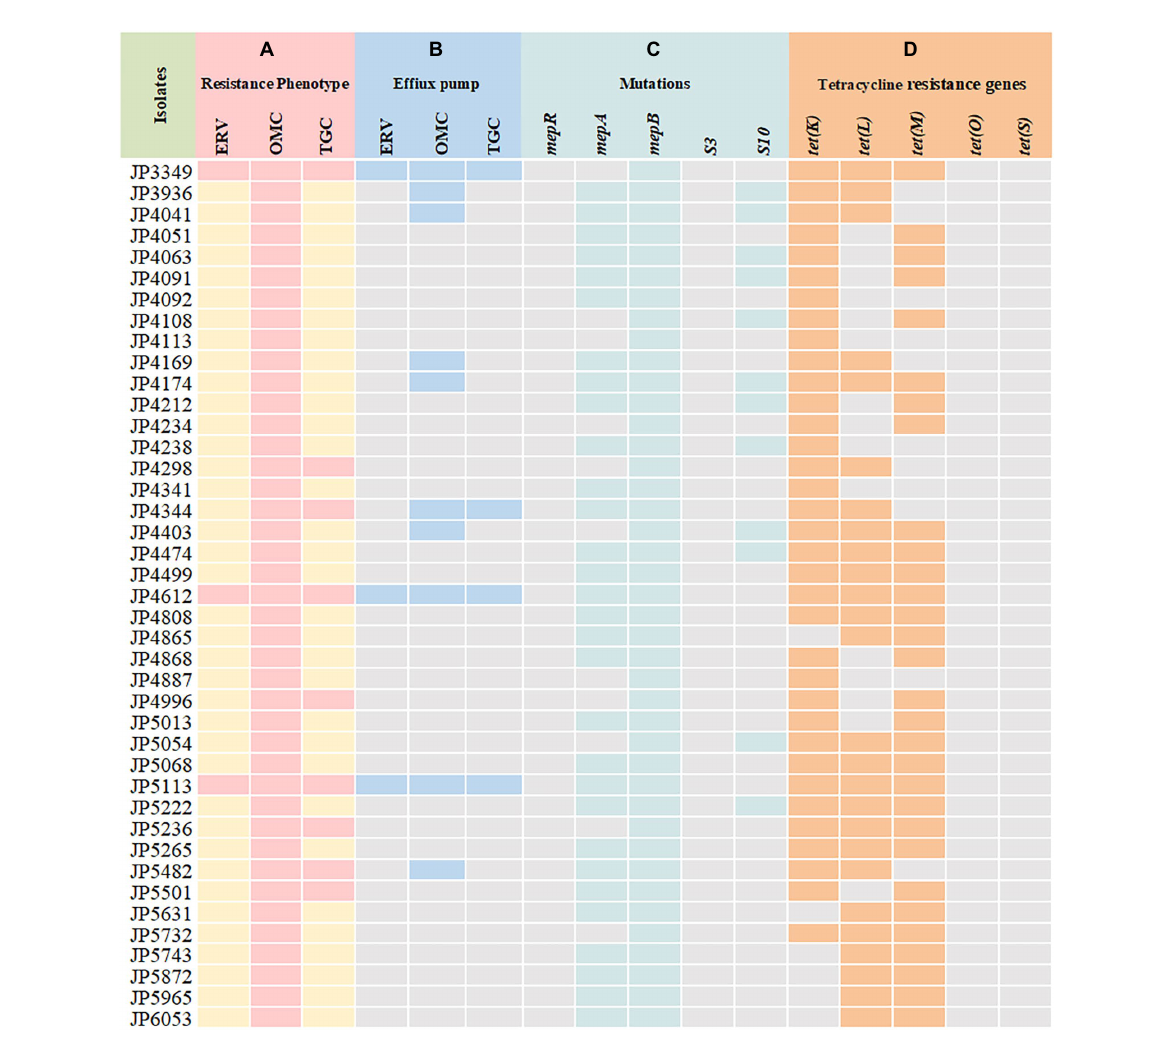
FIGURE 1 Tetracyclines resistance mechanisms determined in the clinical Staphylococcus aureus isolates. (A) Resistance phenotype of S. aureus to tetracyclines; (B) carbonyl cyanide 3-chlorophenylhydrazone (CCCP) was used to detect the activity of efflux pumps; (C) mutations in MepRAB efflux pump-encoding genes and 30S ribosome subunits; (D) PCR detection of tetracycline resistance genes. ERV, eravacycline; OMC, omadacycline; TGC, tigecycline; pink and yellow rectangles indicate resistant and susceptible phenotypes, respectively; Blue rectangles indicate strains with a positive efflux pump phenotype; Green rectangles represent genetic mutations that are only present in the resistant strains; Orange rectangles indicate strains harboring tetracycline resistance